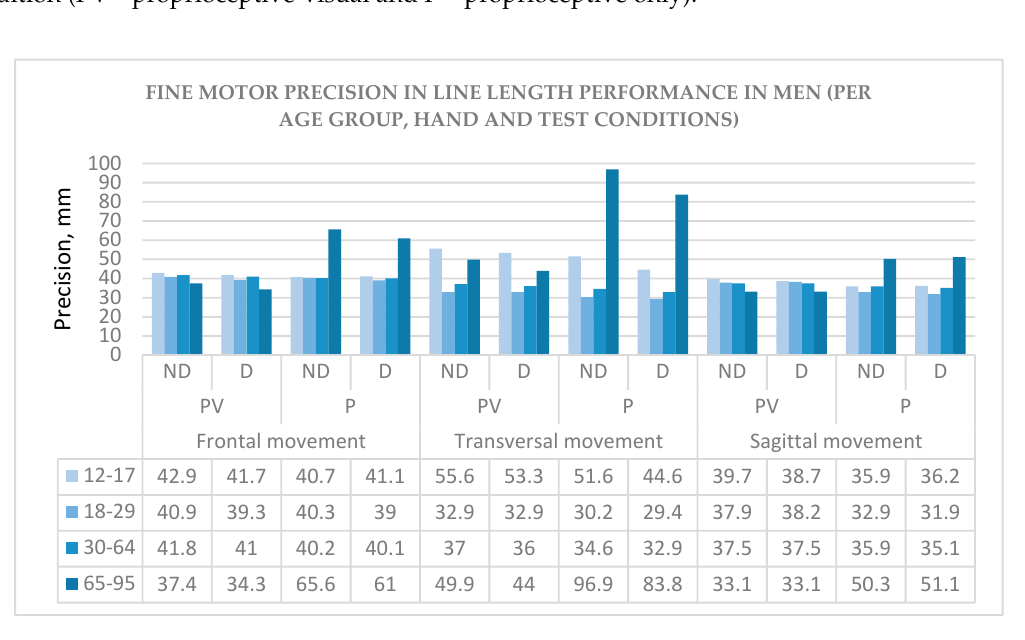
Figure 2. Fine motor precision in men/Note: The model line length is 40 mm.